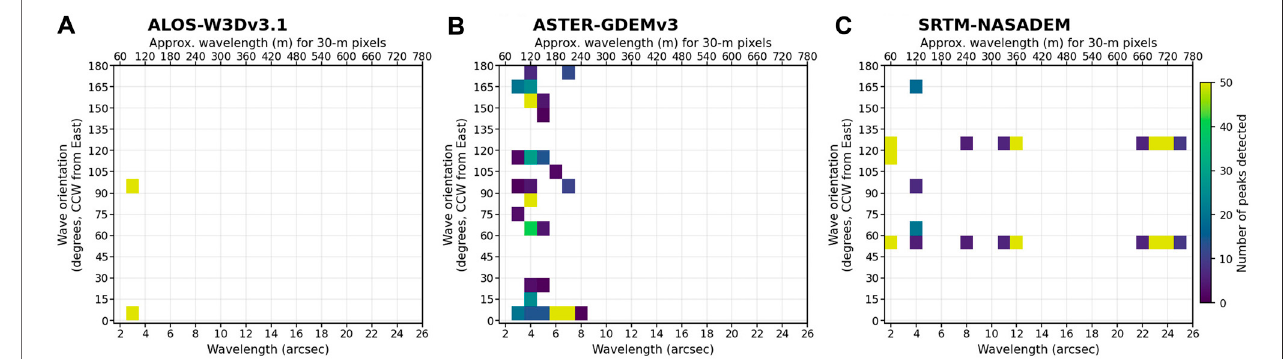
FIGURE 7 | HPHS power peaks found for all 16 square ( ∼ 60-km) tiles. Peak fi nding is done on un-projected 1 arcsec DEMs, and the upper x -axis label shows the approximate wavelength in meters at 30-m pixel resolution. A 2D histogram is used to show the number of peaks, since many peaks are identi fi ed in the 41 separately binnedratioplotsforeachofthe16tiles(656iterations).Thehistogramhasbinsin1-arcsecwavelengthsteps(1pixel)and10 ° orientationsteps.Theresultingpeakcount at each wavelength and orientation bin is shown for (A) ALOS-W3Dv3.1, (B) ASTER-GDEMv3, and (C) SRTM-NASADEM. No peaks werefound above 25 arcsec (25 pixels, ∼ 750 m), norfor the TanDEM-X. The colorscale islimited to50 peaks, but often more werefound. Orientation isgiven ascounter clockwise (CCW) from east, thus 0 ° is east, 45 ° is northeast, 90 ° is north, and so on.